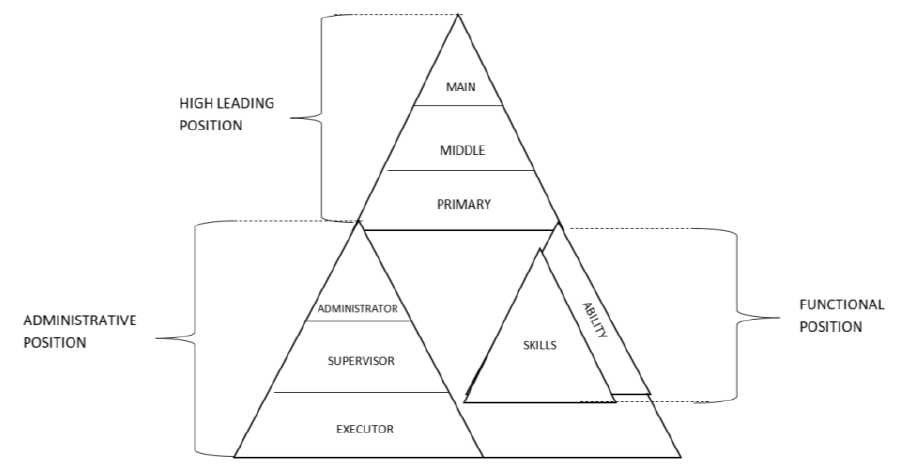
Figure 2: Position of State Civil Apparatus (Civil Servant); Source: Law No. 5 of 2014